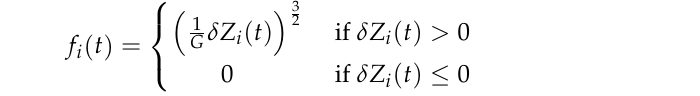
Table 2. Main design parameters of the gear transmissions.